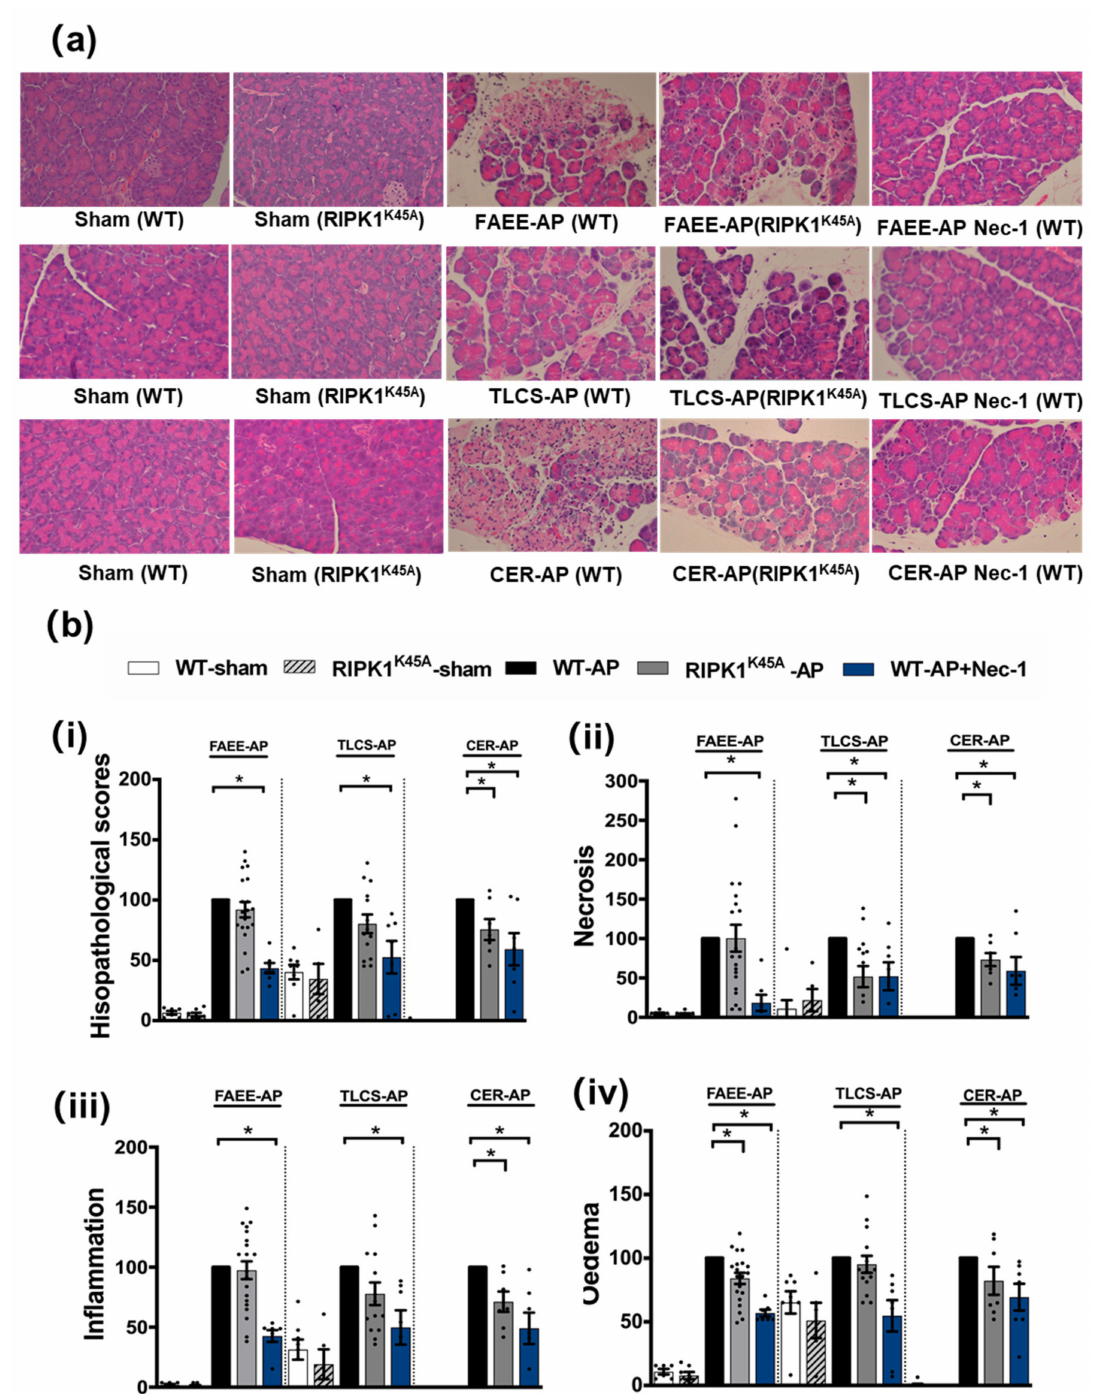
Figure 1. Comparison of histological damage in FAEE-AP, TLCS-AP and CER-AP in RIPK1 K45A and WT mice. ( a ) Represen- tative H and E pancreas images ( × 200) from sham (control), FAEE-AP, TLCS-AP, CER-AP in RIPK1 K45A , WT, and WT with Nec-1 treatment. ( b ) Pancreatic histology scores (( i ) total score, ( ii ) necrosis, ( iii ) inflammation and ( iv ) oedema) in three AP models. Each dot represents a mouse. Responses were normalized to control changes after AP induction in WT and are expressed as the mean ± SEM ( ≥ 5 mice/group). Significant differences between RIPK1 K45A or Nec-1 treatment groups from control are shown as * p <